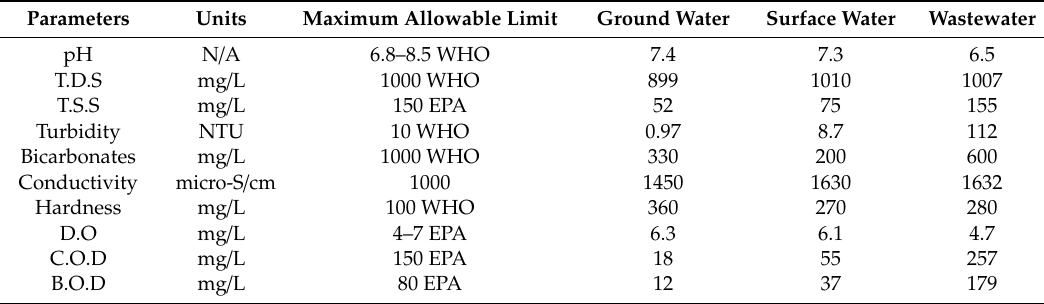
Table 1. Chemical properties of water